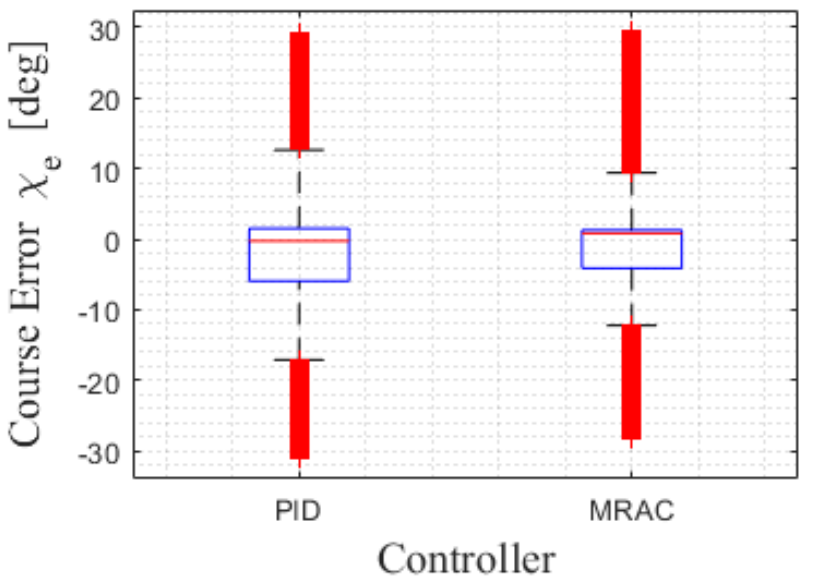
Figure 14. Boxplot showing the total course error when using only the PID controller and when using the